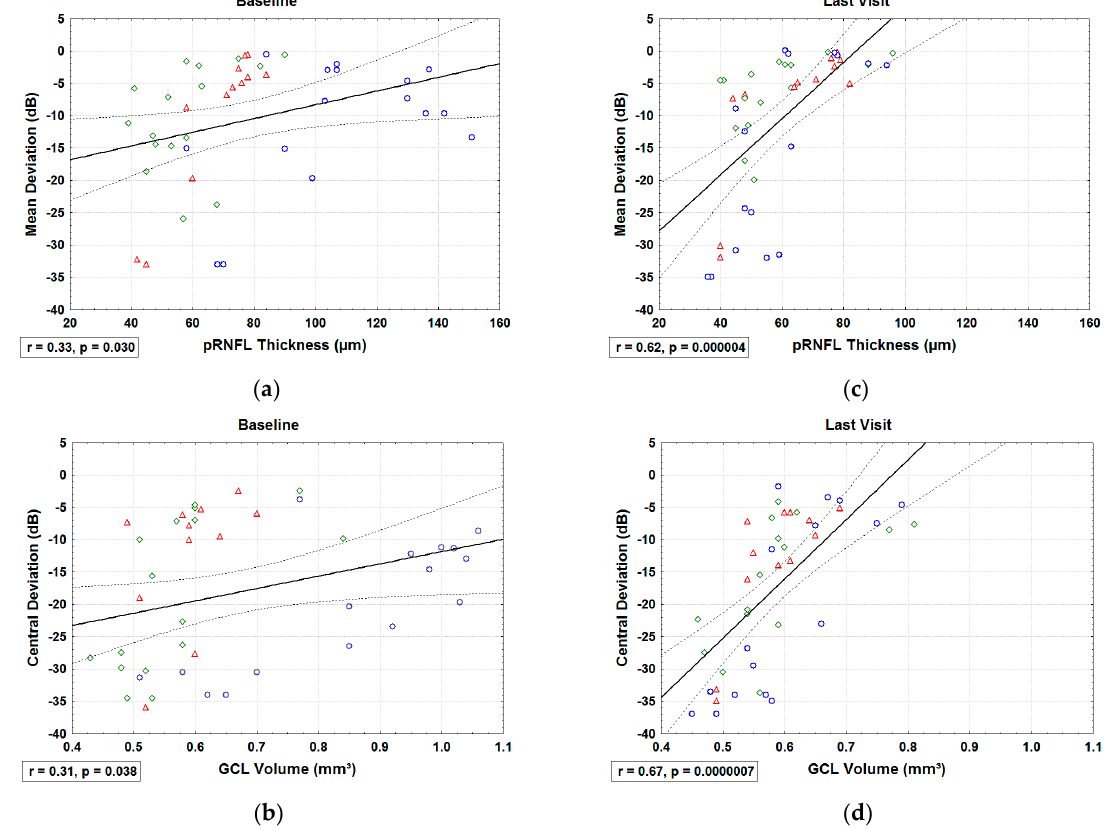
Figure 7. Scatterplots of correlation analyses between visual field and OCT measurements in LHON patients before and after idebenone treatment. Stronger associations were found after treatment. ( a ) Mean deviation (MD) vs. peripapillary retinal nerve fiber layer (pRNFL) thickness at baseline: r = 0.33, p = 0.030. ( b ) Central deviation (CD) vs. macular ganglion cell layer (GCL) volume at baseline: r = 0.31, p = 0.038. ( c ) MD vs. pRNFL thickness at last visit: r = 0.62, p = 0.000004. ( d ) CD vs. macular GCL thickness at last visit: r = 0.67, p = 0.0000007. Blue circles: acute patients, red triangles: early chronic patients, green diamonds: late chronic patients.